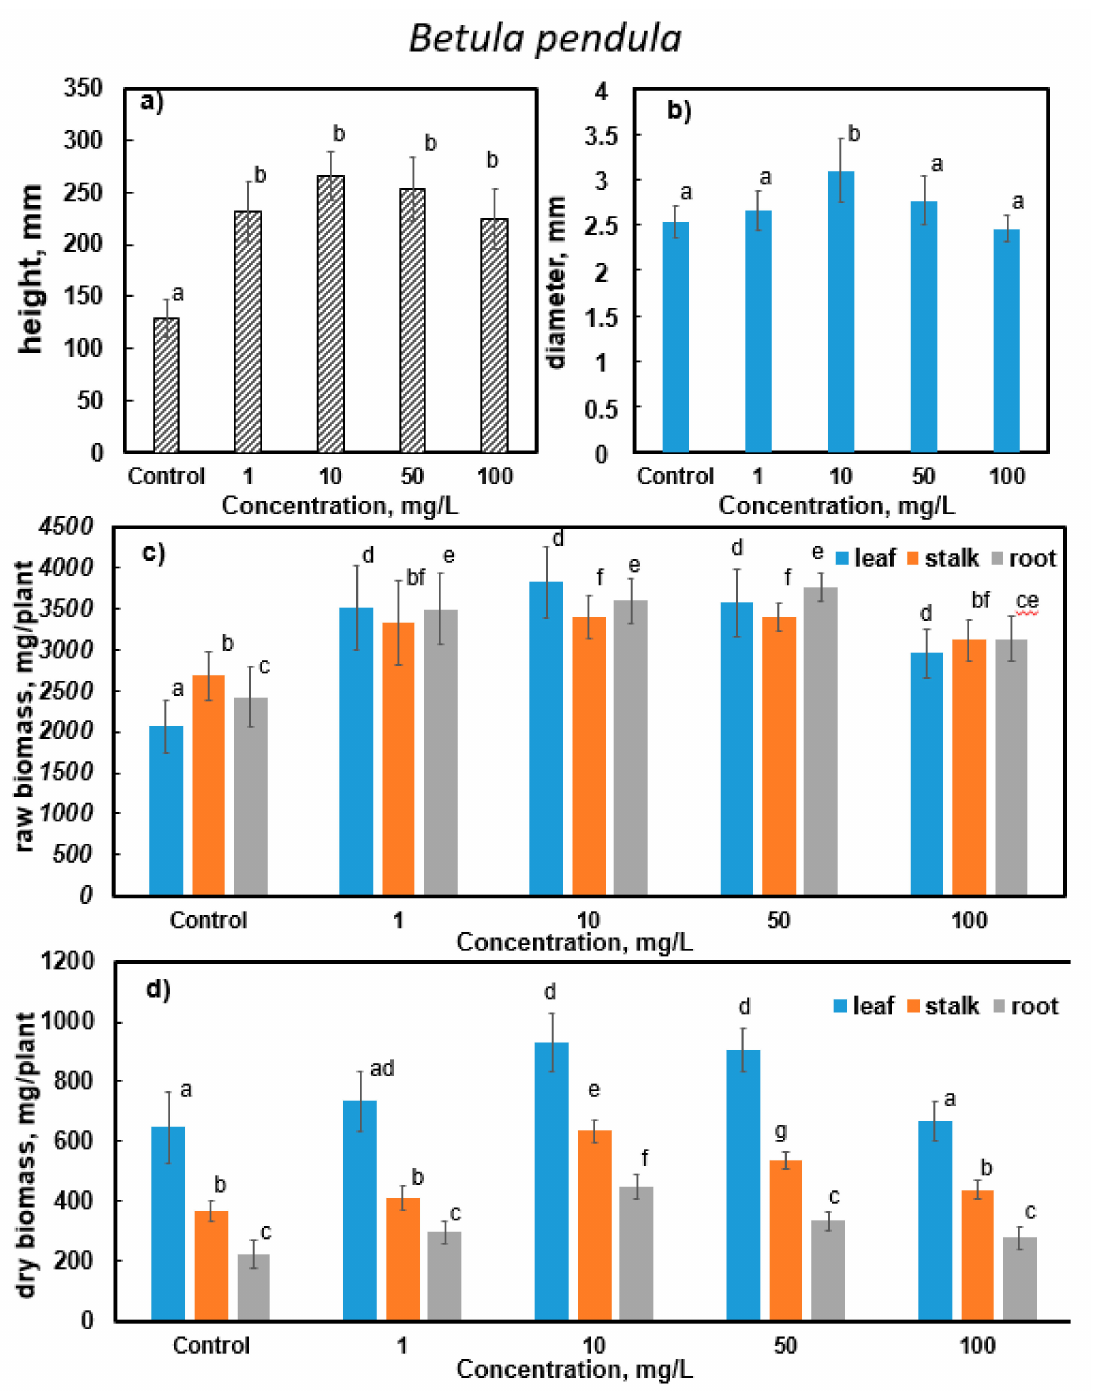
Figure 6. Effect of MWCNTs on height ( a ), diameter ( b ), parameters of wet ( c ) and dry ( d ) biomass of silver birch ( B. pendula ) plants. Bars represent the ± SE of three replicates. Letters on vertical bars represent significant differences between groups according to Duncan’s multiple range test at p <